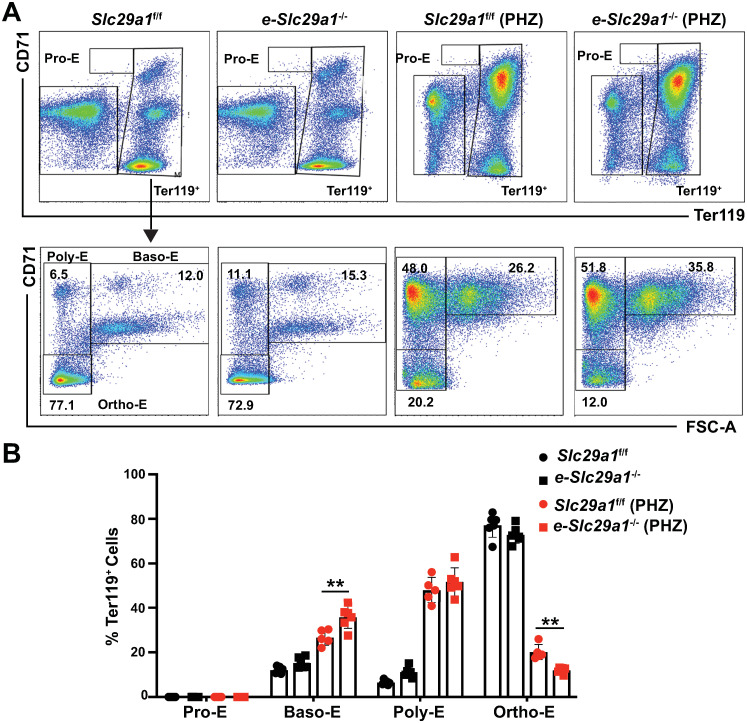
Targeted ablation of Slc29a1 in erythroblasts attenuates erythrocyte regeneration in spleen of an acute anemia mouse model.(A) Representative image of Pro-E, Baso-E, Poly-E, Ortho-E (representing pro-erythroblasts, basophilic erythroblasts, polychromatic erythroblasts and orthochromatic erythroblasts) in spleen from e-Slc29a1-/- and Slc29a1f/f mice. Top panel: Pro-erythroblasts (Pro-E) represent the CD71highTer119- population; Lower panel: In gated Ter119+ erythroblasts, based on CD71 and Ter119 expression level, coupled with analysis of forward scatter (FSC), three stages of erythroid differentiation were defined: basophilic erythroblasts (Baso-E) were Ter119+CD71+ with a greater FSC; polychromatic erythroblasts (Poly-E) were Ter119+CD71+ with a reduced FSC; and orthochromatic erythroblasts (Ortho-E) were Ter119+ CD71-. (B) The frequencies of each erythroblast population. Data were analyzed with a two-way ANOVA, followed by a Tukey’s multiple comparisons test, *p < 0.05, **p < 0.01.